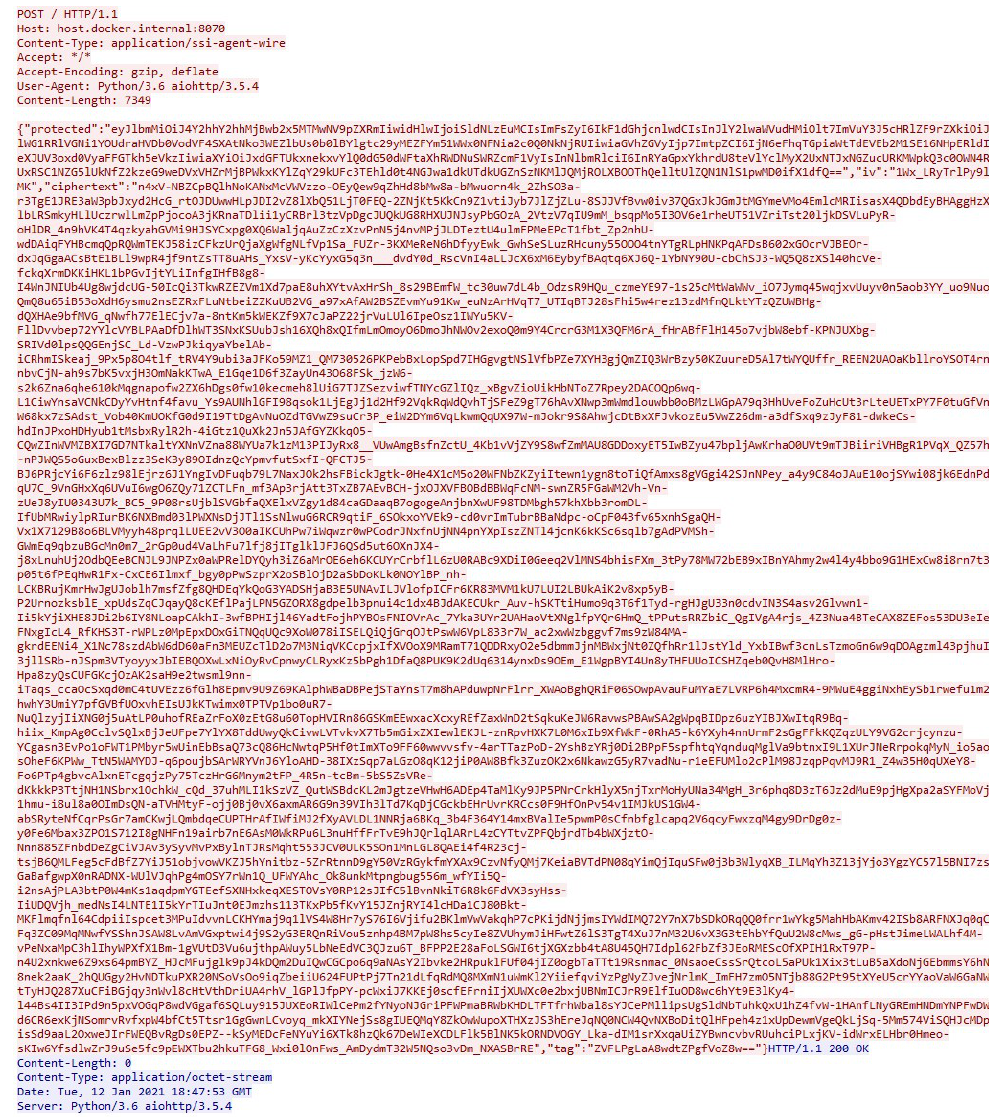
Figure A2. Traffic through the DIDComm protocol is